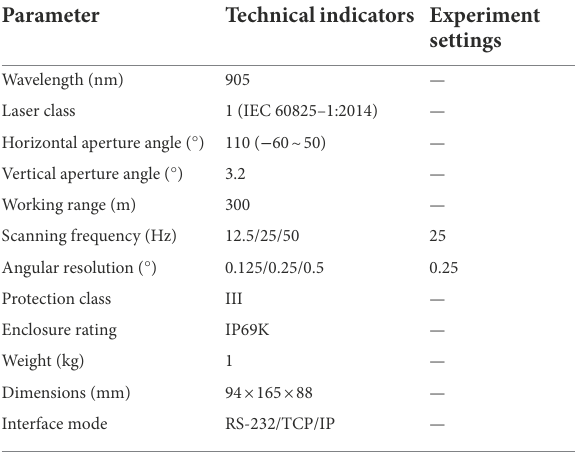
TABLE 1 3D LiDAR sensor specifications.